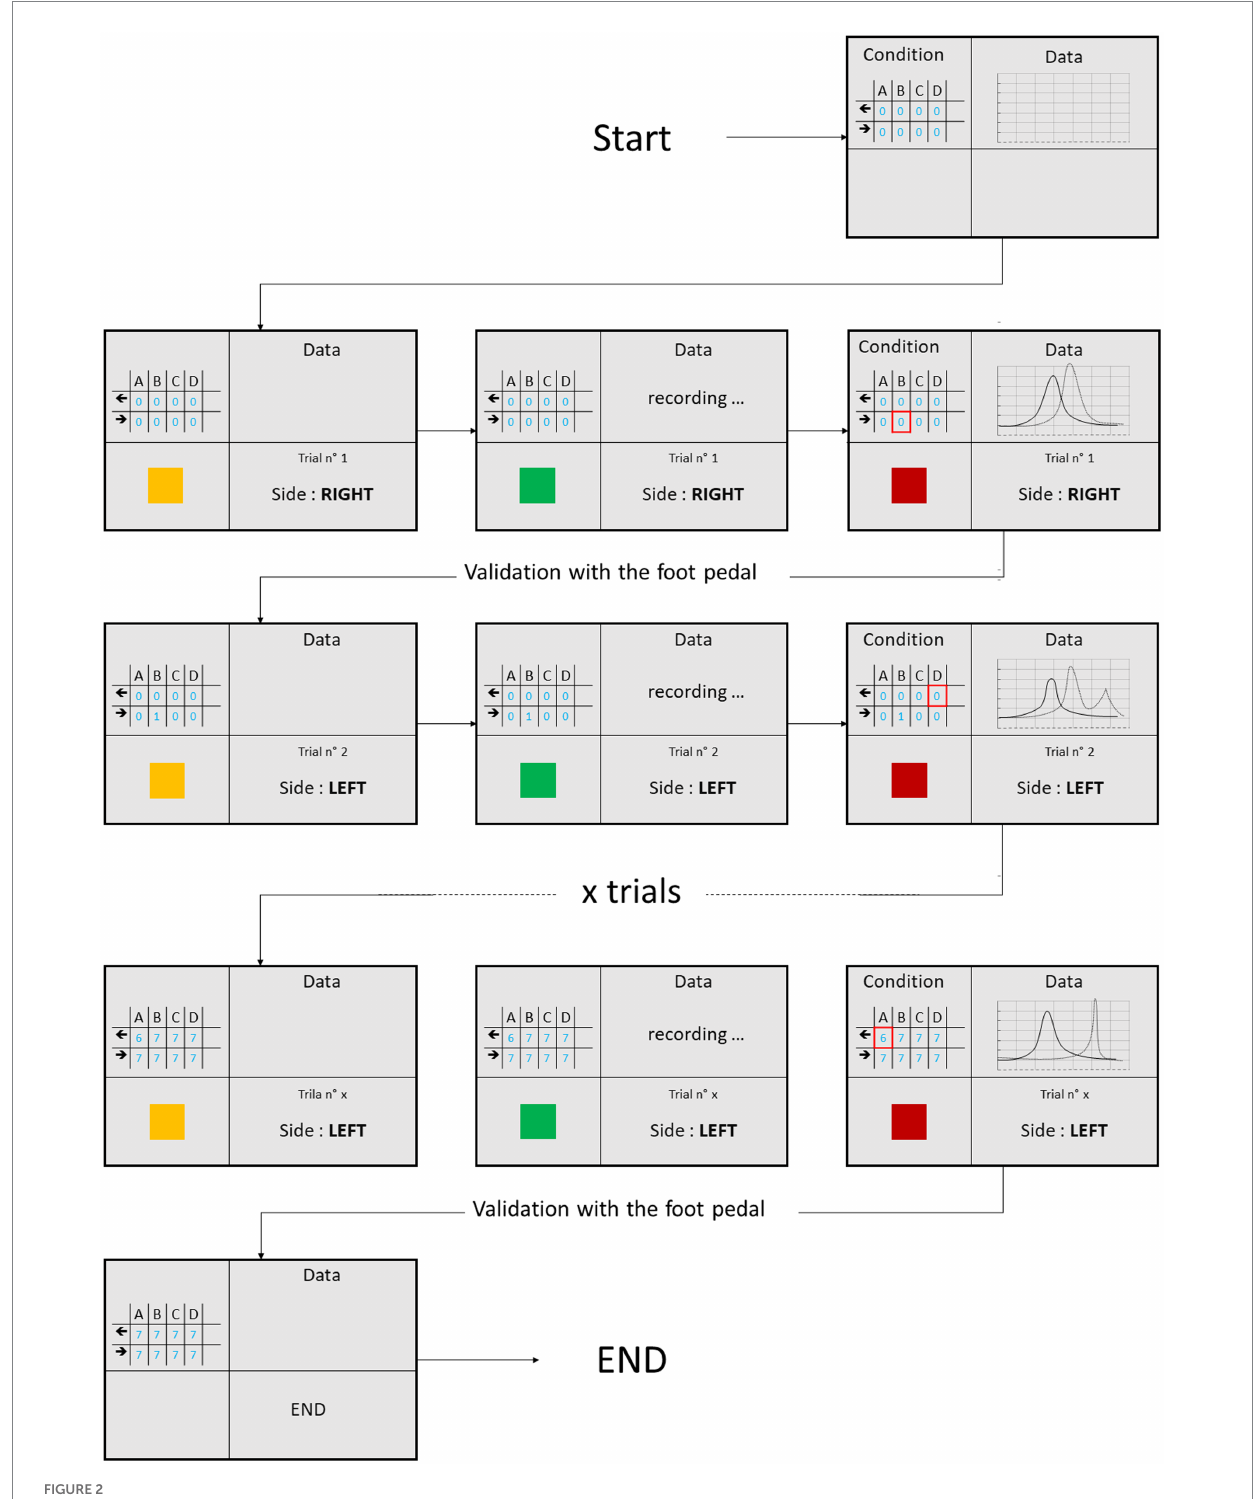
FIGURE 2 Display of screen N ° 1 during the protocol. The lower left side of the screen indicates the action the examiner must do. Yellow: prepare for head impulse; Green: Head impulse; Red; no head movement. The lower right side indicates the randomized direction of the head impulse as well as the total number of trials. The upper right side shows recordings of head and eye position during the last trial. The upper left side of the screen shows the progression of validated trials for the four different conditions (A: normal; B: Freeze; C: Inverse; D Half), leftward and rightward arrows indicate the direction of head rotation. The test ended as soon as seven head impulses for each direction and each condition have been validated by the